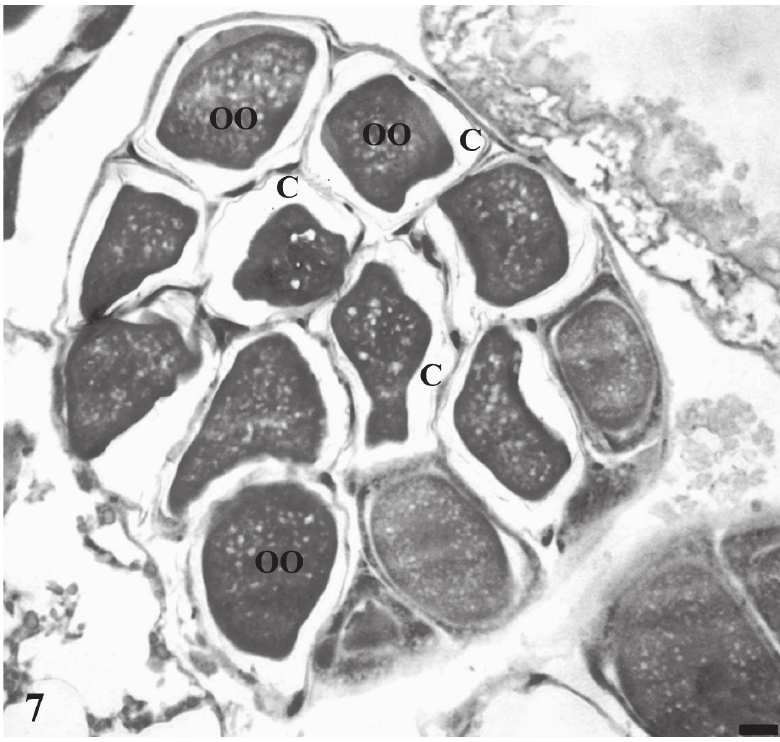
Figure 5 - Mature oocytes (OO) of females of Palmistichus elaeisis (Hymenoptera: Eulophidae) 48 h after their emergence from Tenebrio molitor (Coleoptera: Tenebrionidae) pupae. C - chorion. Bar: